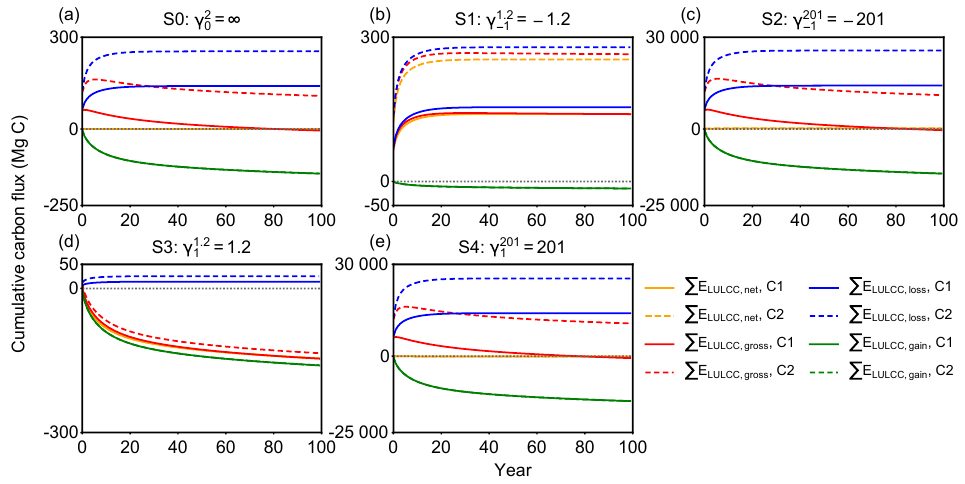
Figure 3. Cumulative carbon flux ( (cid:54)E LULCC ) after an initial forest area change at t = 0 followed by no change in forest area for the different scenarios S0 to S4 in Table 1 with different net and gross initial forest area changes. The response curves used in those bookkeeping model simulations are C1 in solid lines (Table 2) with a secondary-to-secondary forest change at t = 0 and a logarithmic biomass recovery curve with an asymptote, and C2 in dashed lines (primary-to-secondary forest change at t = 0 and a logarithmic biomass recovery curve with an asymptote). The dotted line is the zero line. A positive value of carbon flux indicates carbon emission to the